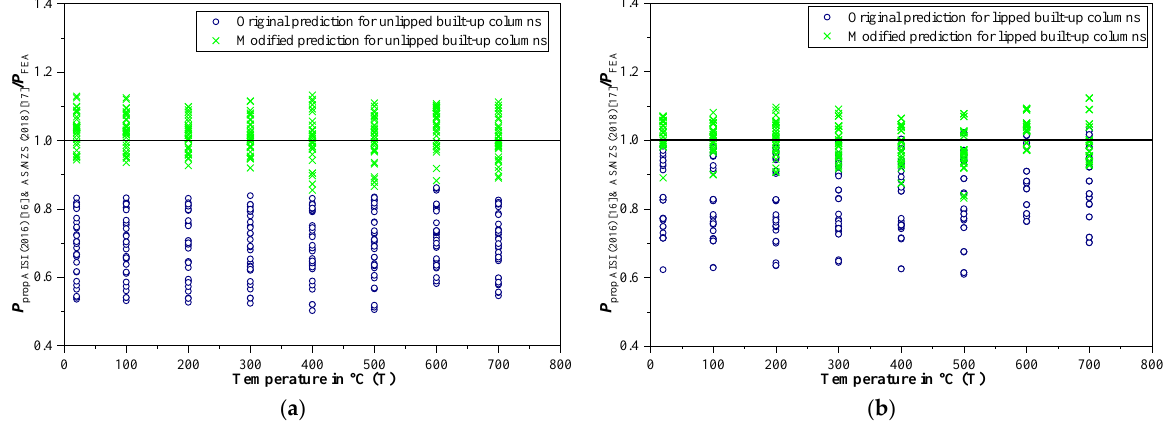
Figure 13. Comparison of FE strengths with proposed design strengths: ( a ) P AS/NZS / P FEA of FTF built-up unlipped channel columns; and ( b ) P AS/NZS / P FEA of FTF built-up lipped channel columns.